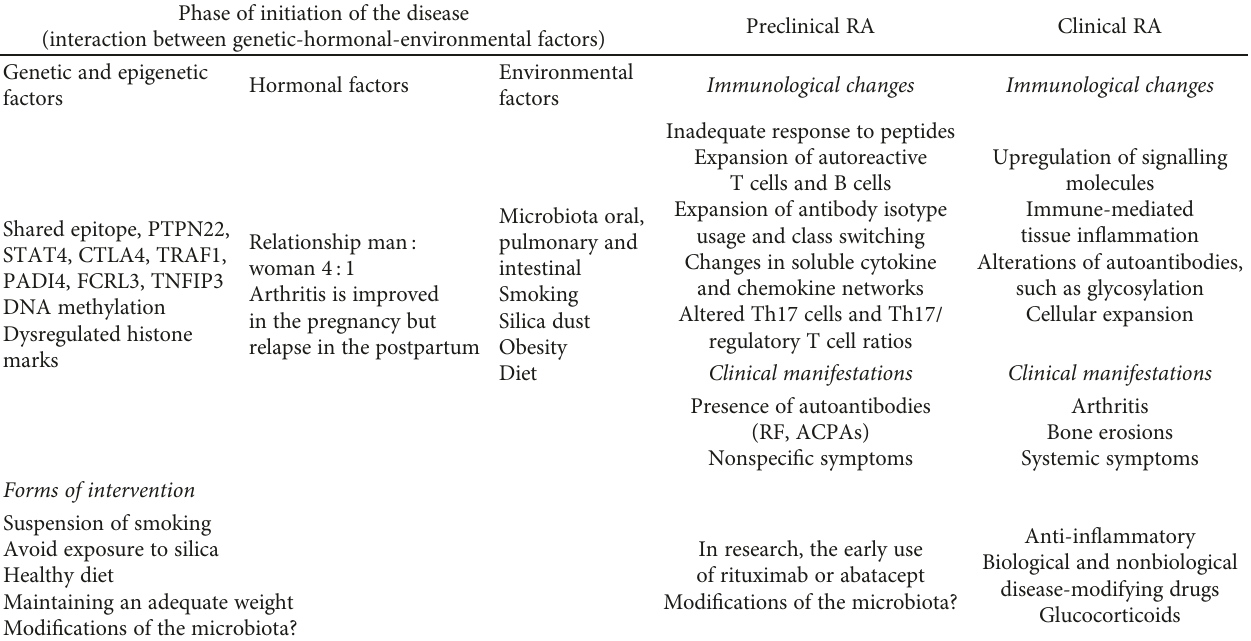
Table 1: Natural history of rheumatoid